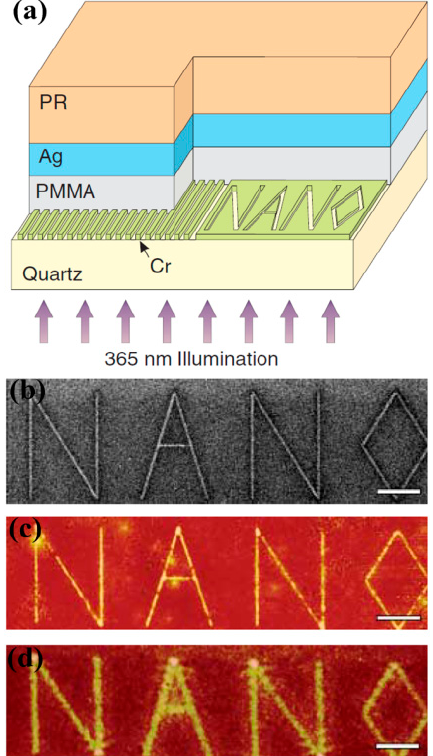
Figure 2. ( a ) Schematic of a silver superlens. ( b ) Object of “NANO” milled by FIB. ( c ) High resolution and fine features with the superlens. ( d ) Low resolution and blurry features without the superlens. Reproduced with permission from [88]. Copyright the American Association for the Advancement of Science, 2005.